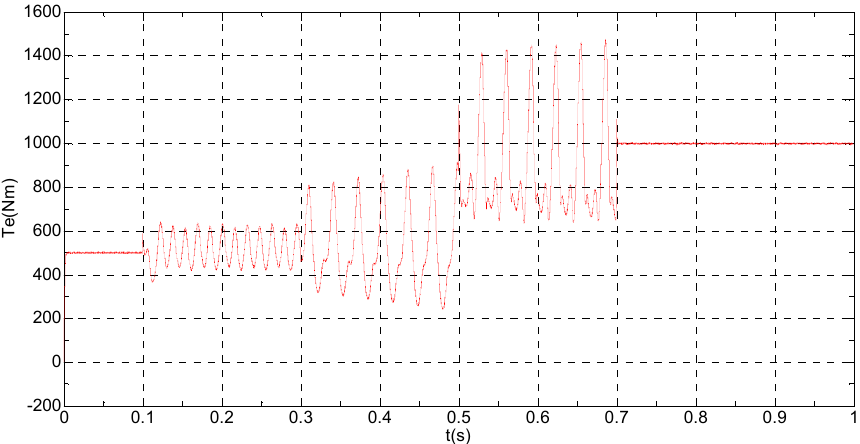
Figure 14. The electromagnetic torque.